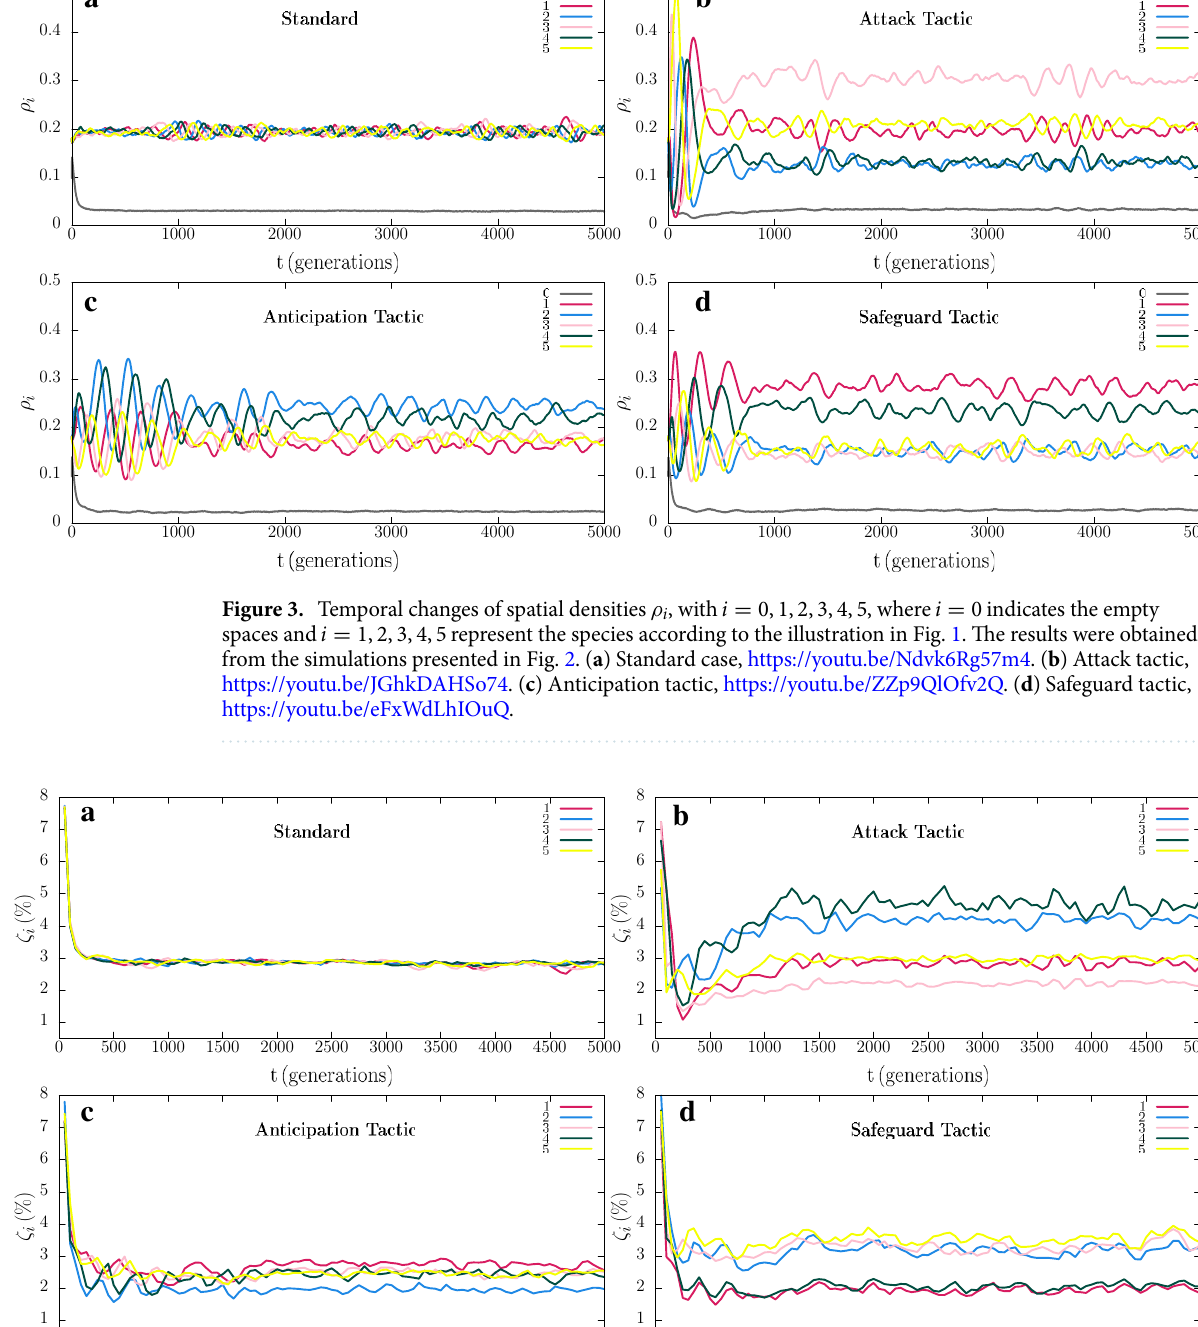
colours identify the species according to Fig. 1, whereas in Fig. 3 the grey line shows the density of empty spaces.